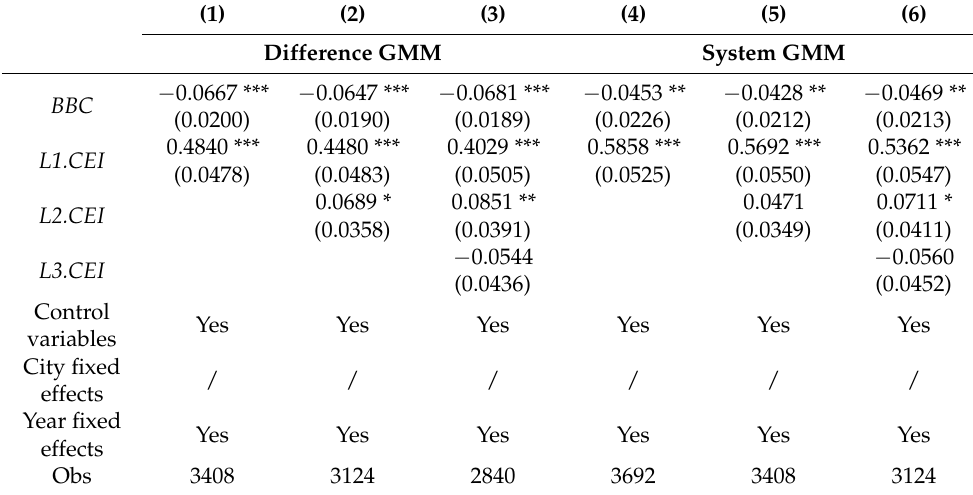
Table 5. Robustness test